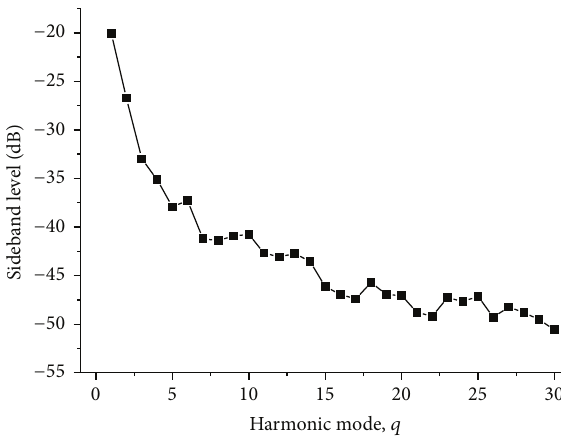
Figure 10: The maximum sideband levels of the first 30 positive harmonics for scan direction of (74 ∘ ,0 ∘ ) for solution A in Figure